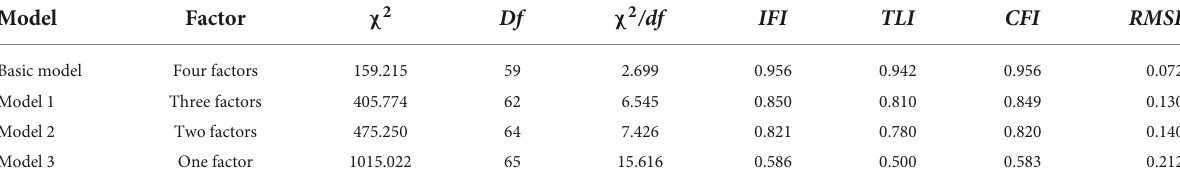
TABLE 2 Confirmatory factor analysis.